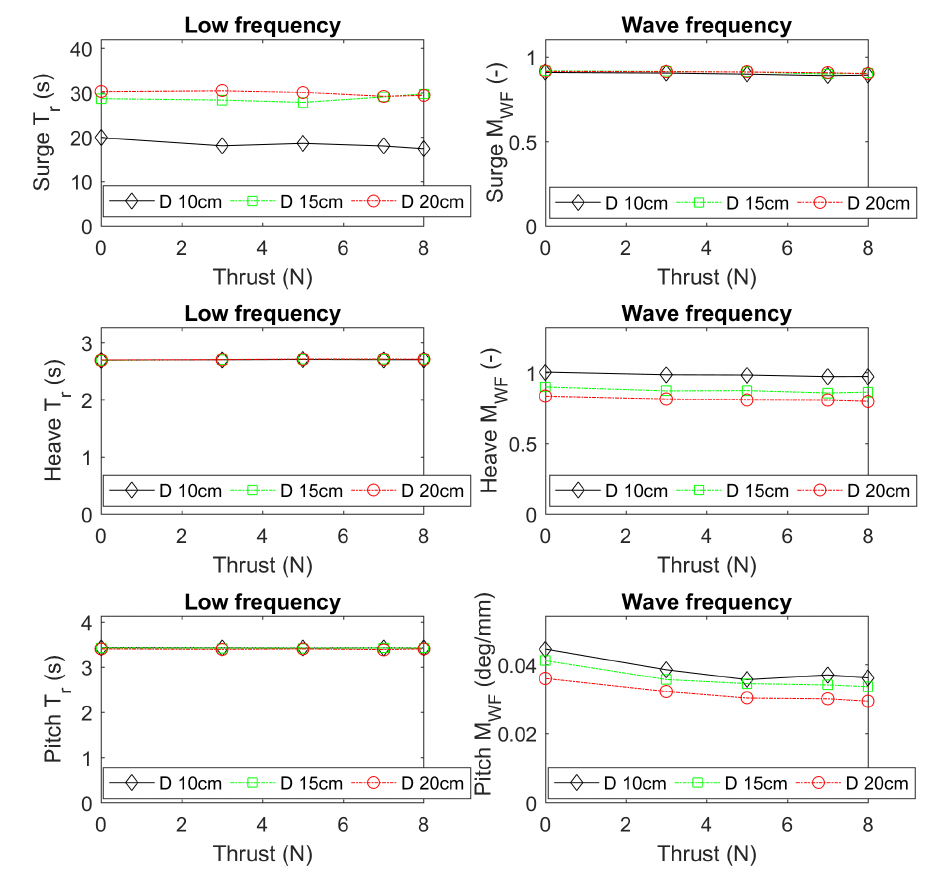
Figure 25. Metrics T r (left column) and M WF (right column) for JONSWAP T p = 2.58 s, H s = 10, 15, and 20 cm for surge (top row), heave (middle row), and pitch (bottom row) at thrust levels of 0, 3, 5, 7, and 8 N for campaign